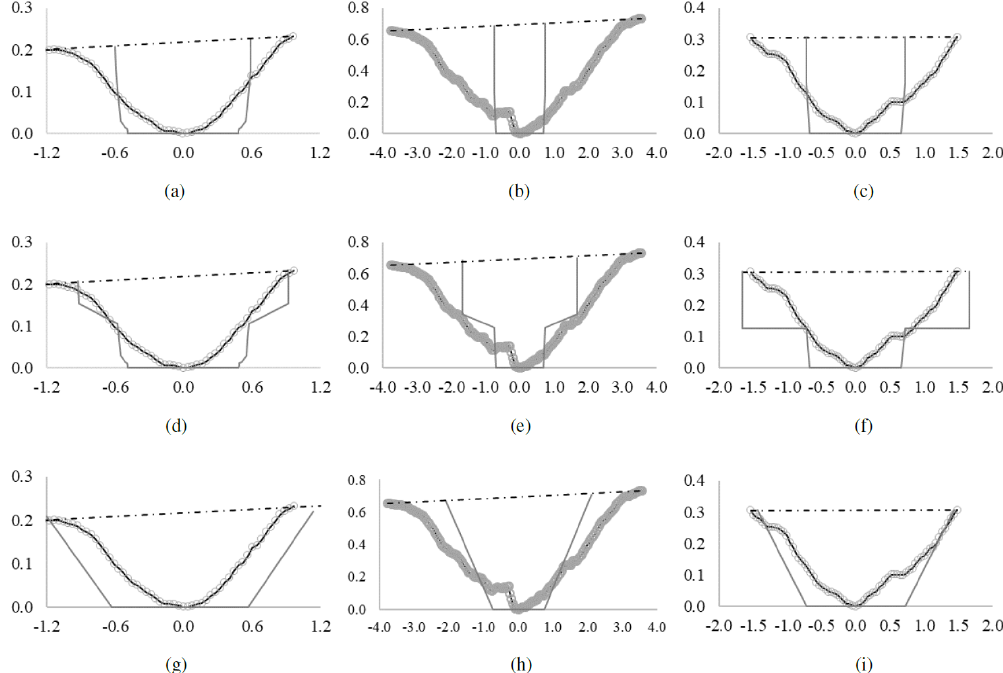
Figure 8. Some examples of the gully cross sections measured (black line with circles) and the modelled (dark grey line) geometry. Panels (a) , (b) and (c) show the output of the Foster and Lane (1983) model; panels (d) , (e) and (f) show the output of the adapted Foster and Lane model with the parameter λ ; and panels (g) , (h) and (i) show the result from the Sidorchuk (1999) model (SM). Distances are give in metres. The section in (a) , (d) and (g) is obtained from gully 1; the section in (b) , (e) and (h) is from gully 2; and the section from (c) , (f) and (i) is from gully 3.